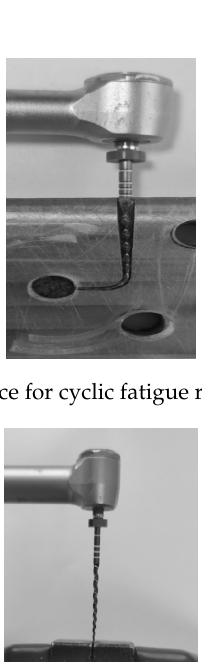
Figure 2. Device for torsional resistance tests.